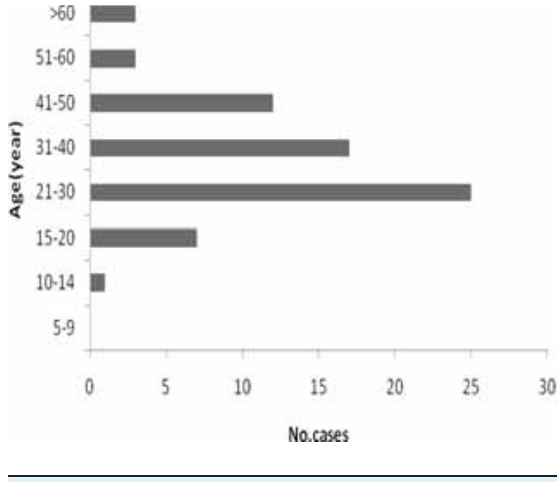
Figure 2. Age distribution of DF cases, having a platelet count < 50,000/mm